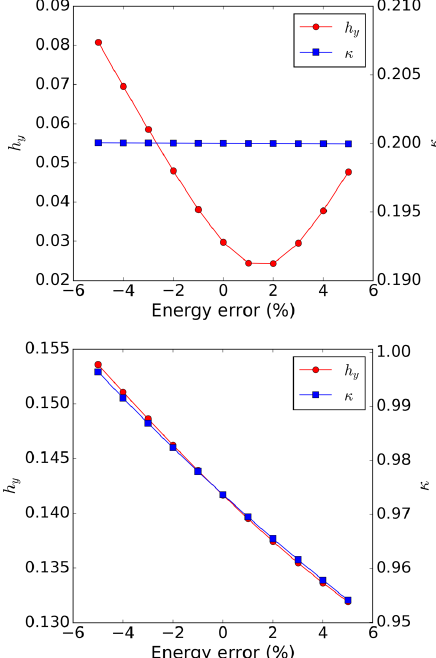
FIG. 6. Sensitivities of the measurement error to the energy used in the transfer matrix calculation. Top: Q1 is used for scanning. Bottom: Q3 is used for scanning.